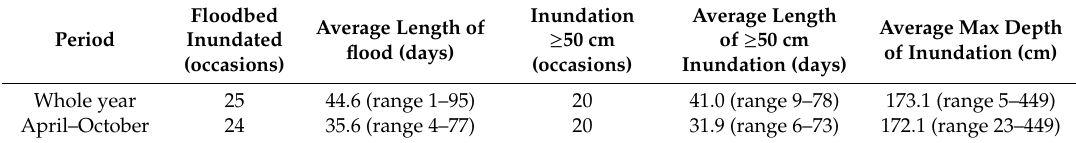
Table A1. Flooding history of river Tisza at Szeged between